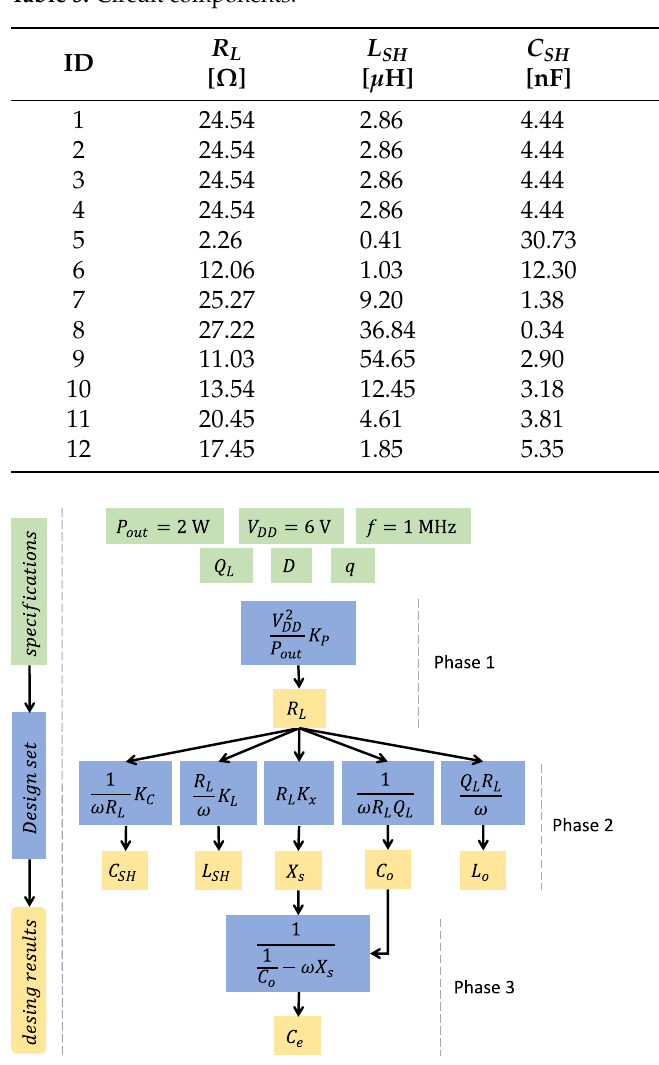
Table 5. Circuit components.